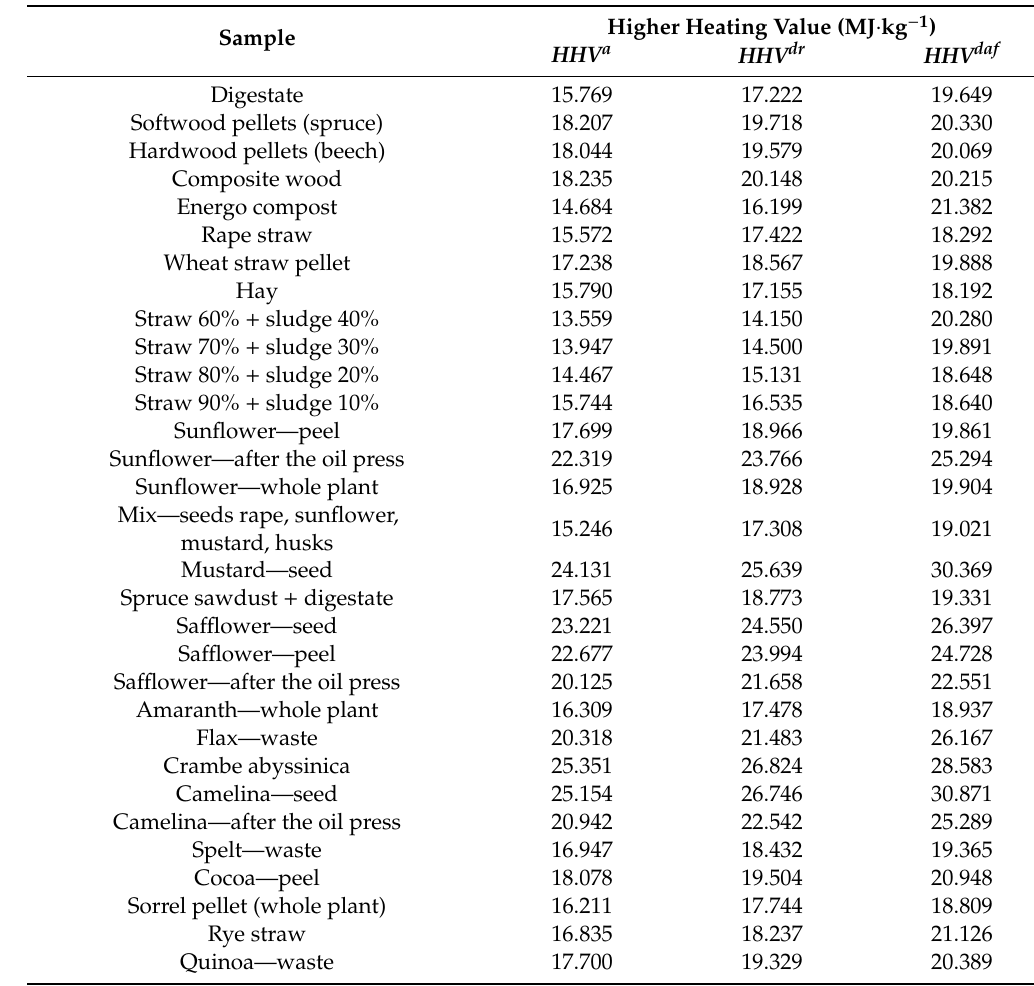
Table 9. Higher heating value in the original sample of HHV a , dry matter HHV dr , and combustible HHV daf